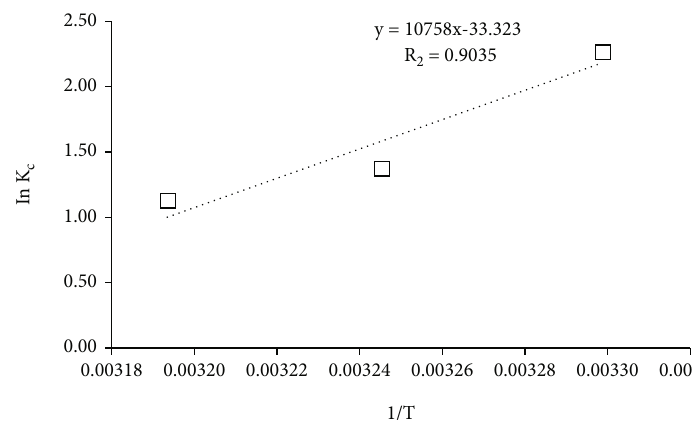
Figure 11: The plot of In K against 1/ T was employed to determine the thermodynamic study parameters. c Table 4: The thermodynamic parameters for this study. T (K) Δ G o (kJ · mol -1 )